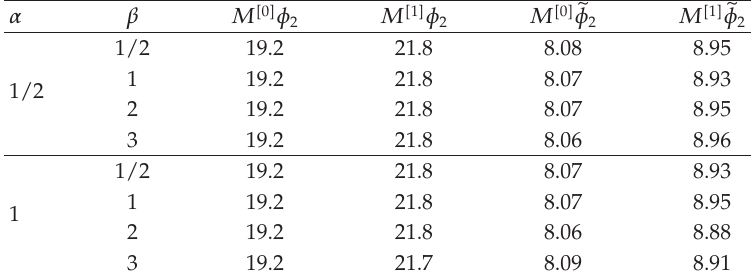
Table 4: Maximum relative % errors of the approximate solutions φ 2 (cid:3) x (cid:4) and perturbation